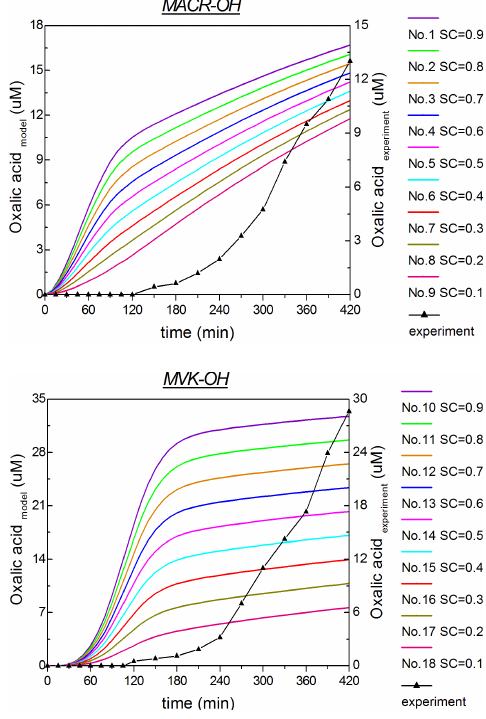
Fig. 11. Evaluation of the effect of stoichiometric coefficients (SC) of glyoxylic acid and glycolaldehyde on the oxalic acid yield (simu- lation No. 1–9 for MACR–OH and simulation No. 10–18 for MVK–